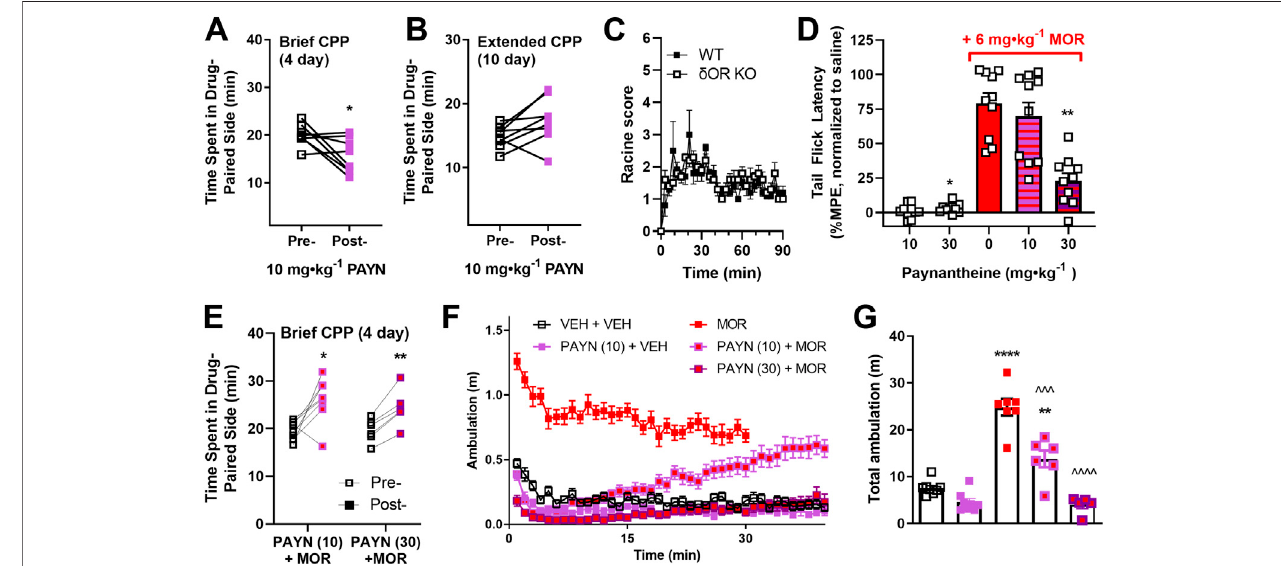
FIGURE2| Antagonisticactionofpaynantheine invivo .TheagonisticandantagonisticactionsofkratomalkaloidpaynantheinewerefurtherinvestigatedinC57Bl/6 mice. Paynantheine (10 mg · kg − 1 , i.p. PAYN) was evaluated in a (A) 4-day and (B) 10-day model of conditioned place preference (CPP, two vs. four drug conditioning sessions, respectively, n (cid:2) 8 each). (C) Seizure activity induced by paynantheine (30 mg · kg − 1 , i.p.) was evaluated in male δ OR KO and WT mice ( n (cid:2) 5 per group). (D) Paynantheine(10and30 mg · kg − 1 ,i.p.)wastested foragonistand antagonisticpropertiesinmalemice ( n (cid:2) 10per dose) via thetail fl ickthermalnociceptionassay. For the antagonist assays, morphine (6 mg · kg − 1 , s.c., MOR) was administered 10 min following a dose of paynantheine (10 or 30 mg · kg − 1 , i.p.). Nociception data are expressed asmaximumpossibleeffect (%MPE)normalizedtoasalinebaseline (treatment – salinebaseline). (E) Paynantheine(10and30 mg · kg − 1 ,i.p.)wasevaluatedfor agonist and antagonist activity in an acute model of conditioned place preference by administering 10 min prior to morphine (6 mg · kg − 1 ) or the vehicle ( n (cid:2) 8 for 10 mg · kg − 1 doses, n (cid:2) 6 for 30 mg · kg − 1 dose). Locomotor data were extracted from the conditioning sessions of the CPP experiments in (A , E) and is shown as (F) ambulationovertimeand (G) totalambulation(totalareaundercurve).Forcomparisonin (F , G) ,locomotordataformorphine(6 mg · kg − 1